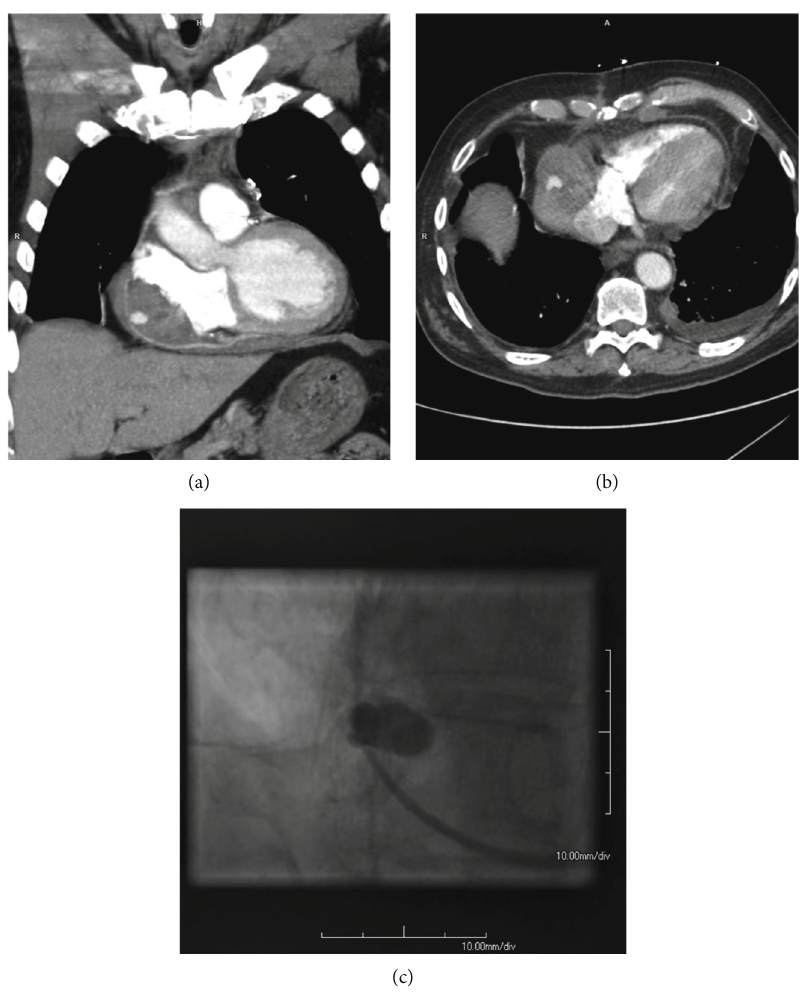
Figure 1: Pseudoaneurysm arising from a CABG graft. (a) and (b) A blush of contrast consistent with a potential pseudoaneurysm could be seen arising from the SV aorta-rPDA graft. It was embedded in a mediastinal hematoma. (c) Left heart catheterization con fi rmed the presence of a pseudoaneurysm arising from the SV aorta-rPDA